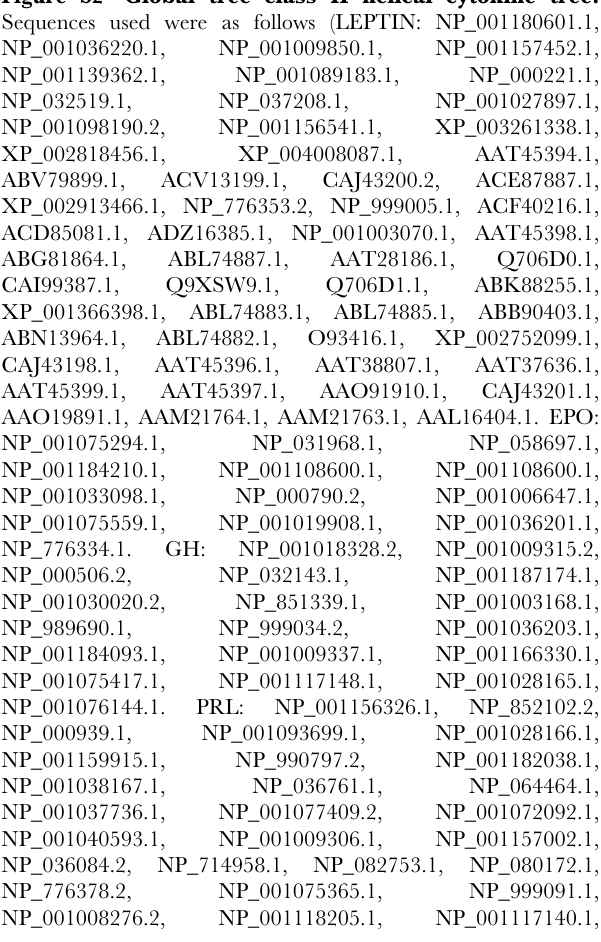
Figure S2 Global tree class II helical cytokine